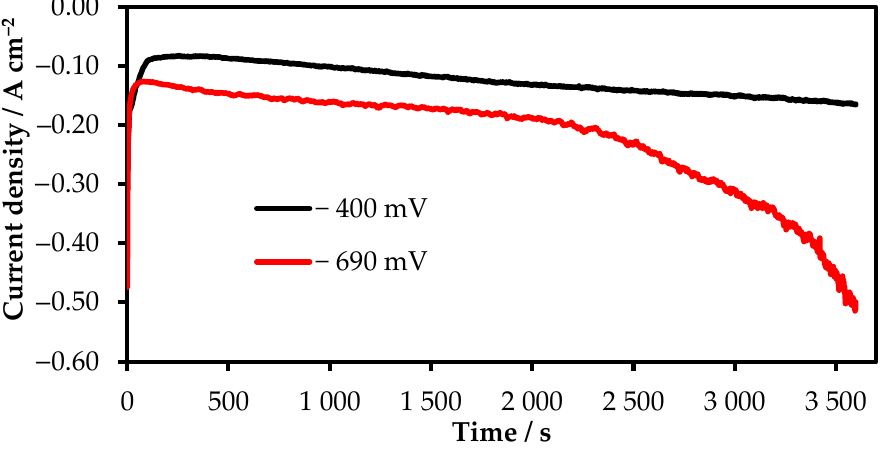
Figure 7. Chronoamperogram of potentiostatic electrolysis of 6 wt.% KReO 4 in molten KF-KBF 4 -B 2 O 3 on a platinum wire electrode. RE:Re; CE:Re.